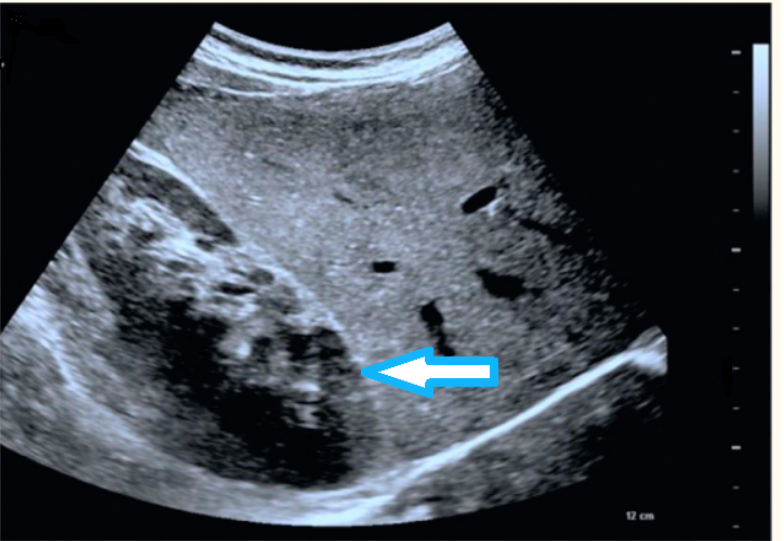
Figure 2. Example of B-mode image of the right liver lobe and right kidney obtained with a convex probe. The kidney is indicated by the arrow